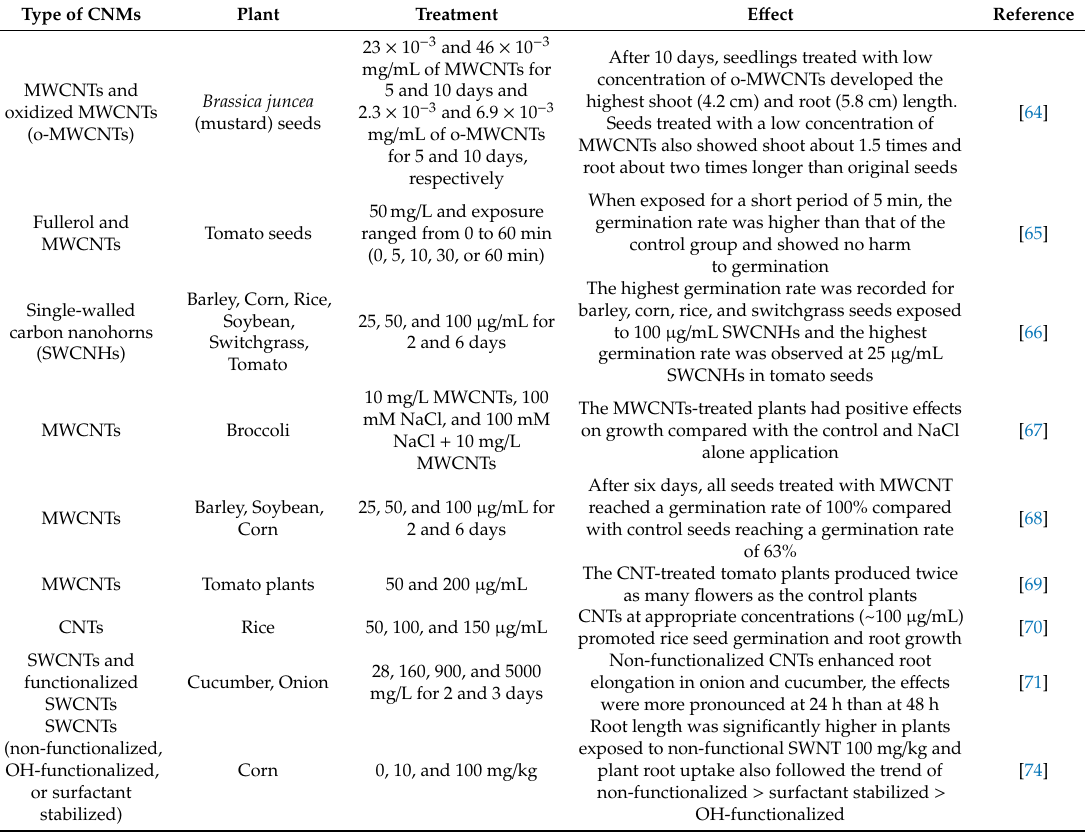
Table 3. The e ff ects of di ff erent carbon nanomaterials (CNMs) on plant and crop growth. Type of CNMs Plant Treatment E ff ect